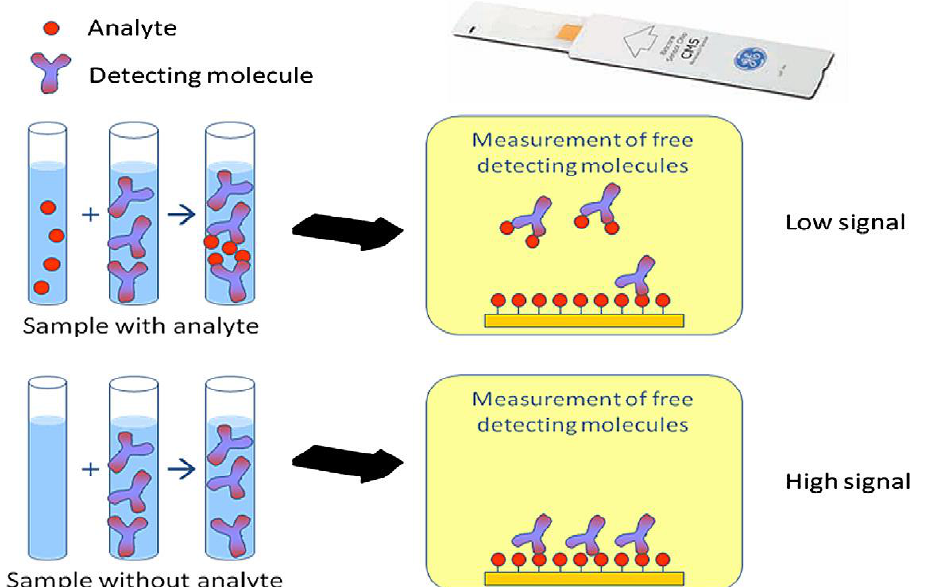
Figure 12. Schematic showing the principle of immobilization on a biosensor